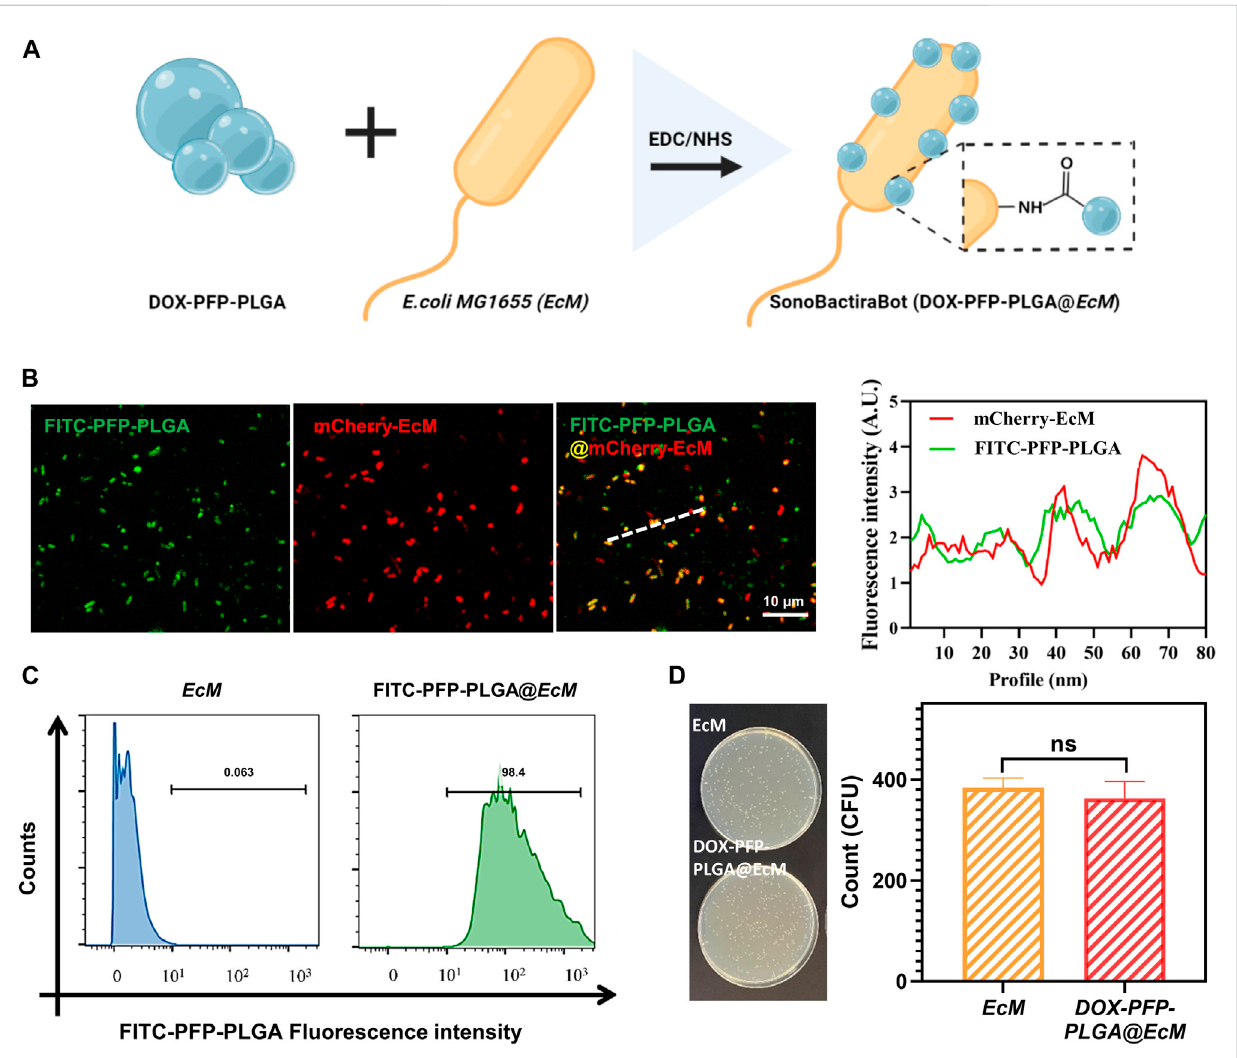
FIGURE 3 Construction and characterization of SonoBacteriaBot. (A) The schematic diagram of SonoBacteriaBot, showed DOX-PFP-PLGA attached to EcM (created with Biorender.com). (B) Confocal microscopy images and intensity of the underlined FITC-PFP-PLGA, mCherry- EcM , and FITC-PFP-PLGA @mCherry- EcM . (C) FlowcytometryhistogramsobtainedfromFITC-PFP-PLGAnanodropletsattendedandnon-attended EcM. (D) Live/Deadbacteriaof DOX-PFP-PLGA nanodroplets attended and non-attended EcM